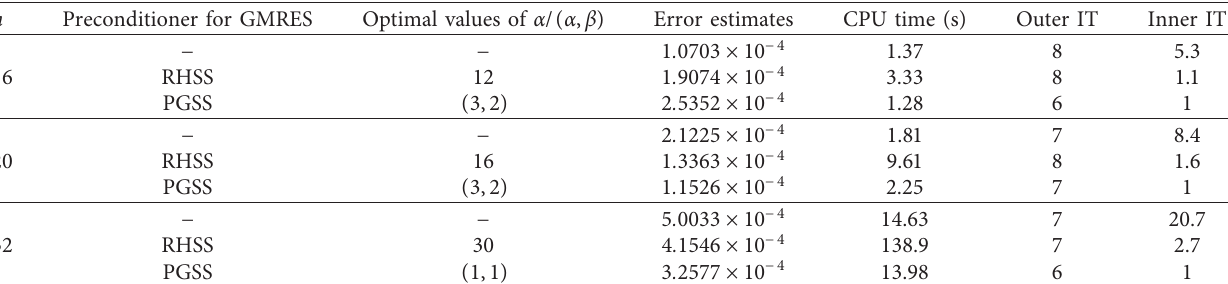
Table 9: Numerical results of preconditioned inexact Newton methods for v � 0.1 and η � 0.1. n Preconditioner for GMRES